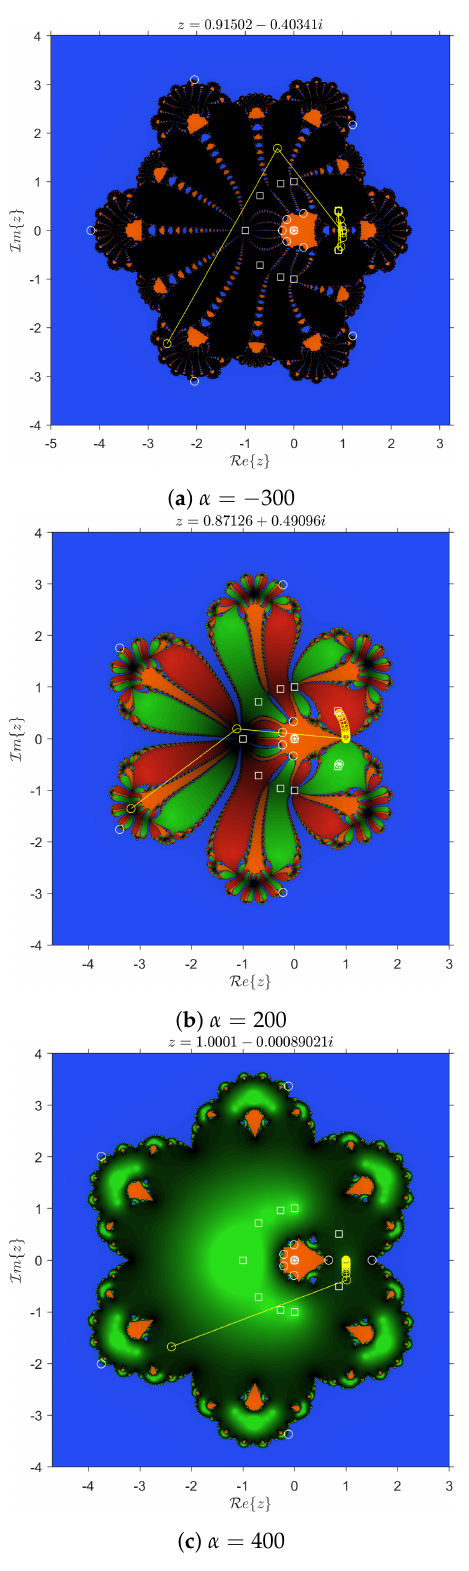
Figure 5. Dynamical planes for methods outside the stability region (basin of attraction of 0 in orange color; in blue color, the basin of ∞ ; in green or red color, the basin of attracting strange fixed